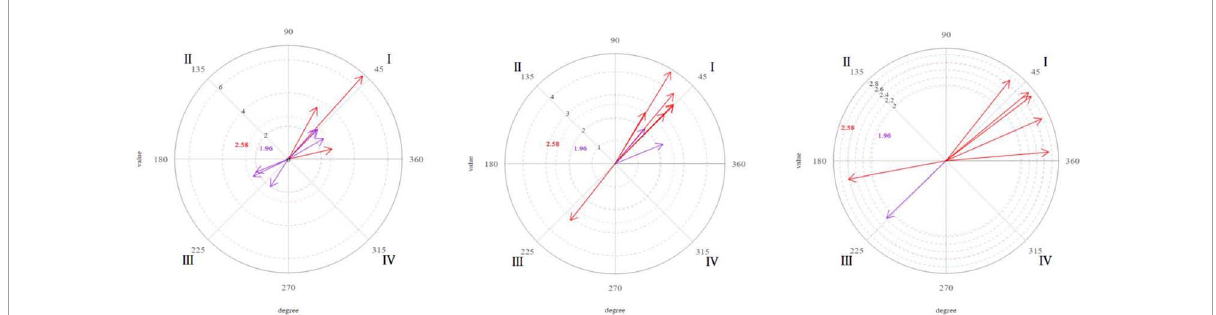
FIGURE4 Graphic representation of the significant (purple) and very significant (red) vectors obtained in the polar coordinate analysis. Focal behavior “Gaze” as the center of the analysis and all the others as conditional of sessions 9, 16, and 20 (from left to right).